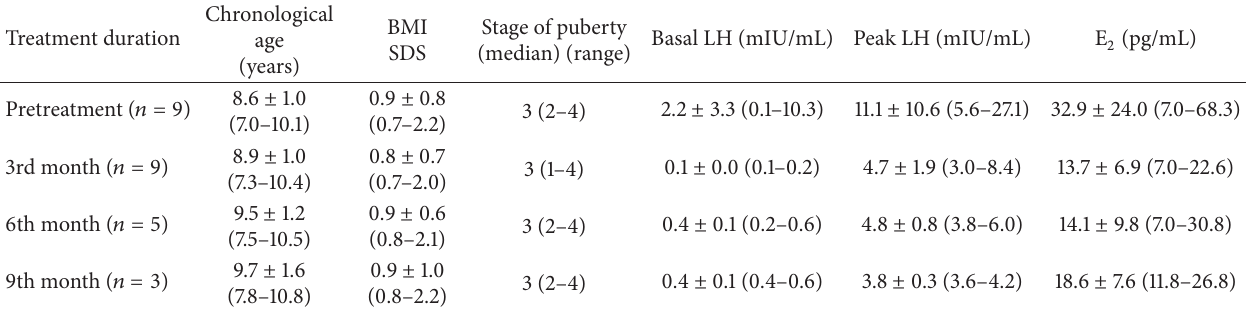
Table 3: Characteristics of patients without HPG axis suppression (mean ± SD) (range).